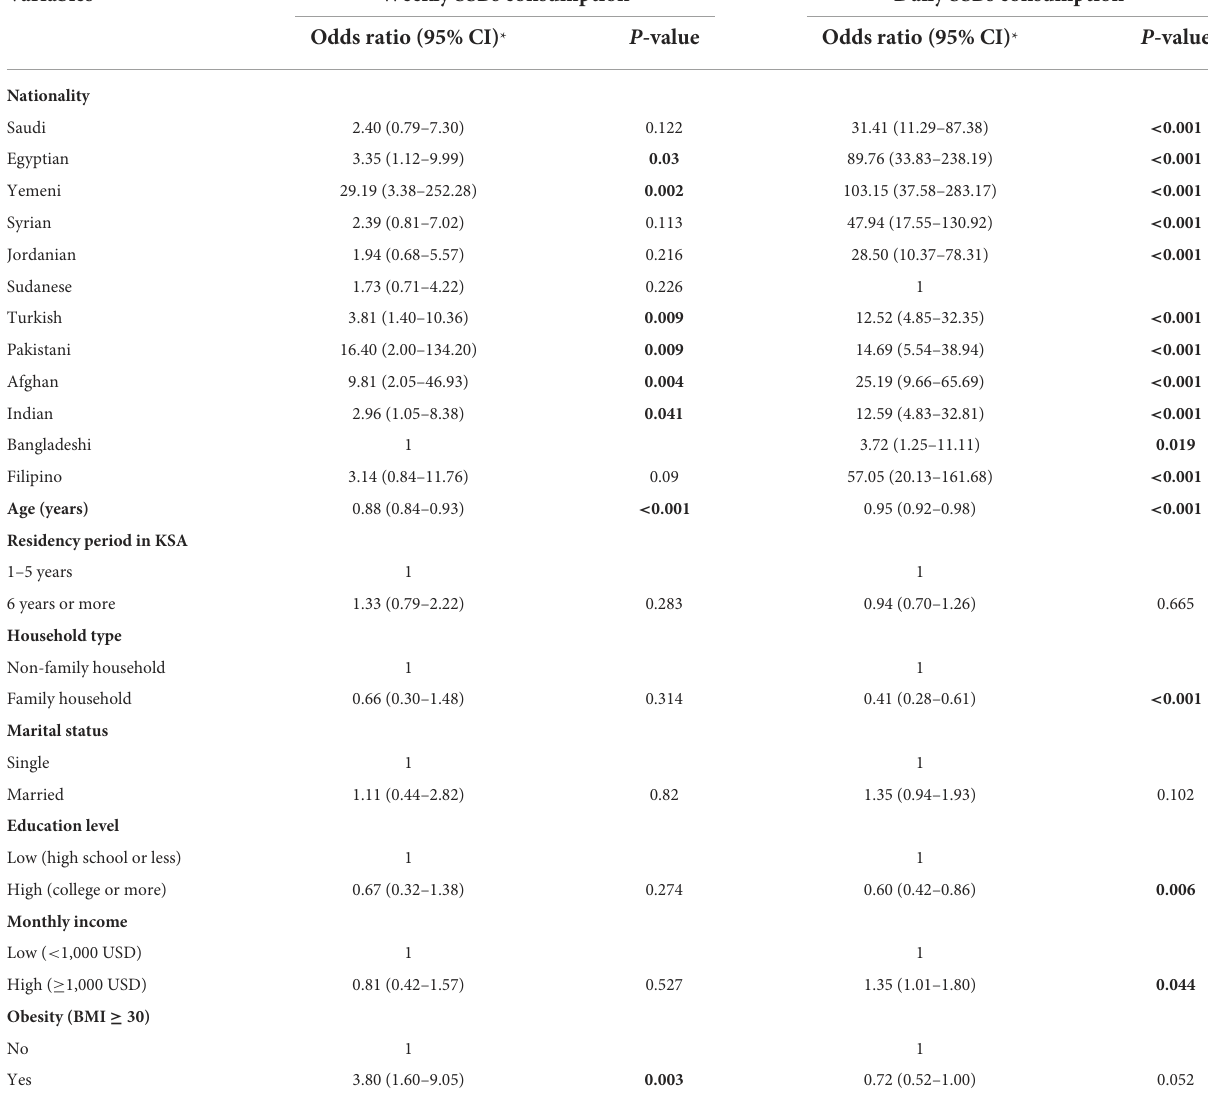
TABLE 3 Odds ratios of weekly and daily sugar-sweetened beverages (SSBs) consumption among study participants for sociodemographic variables and obesity.